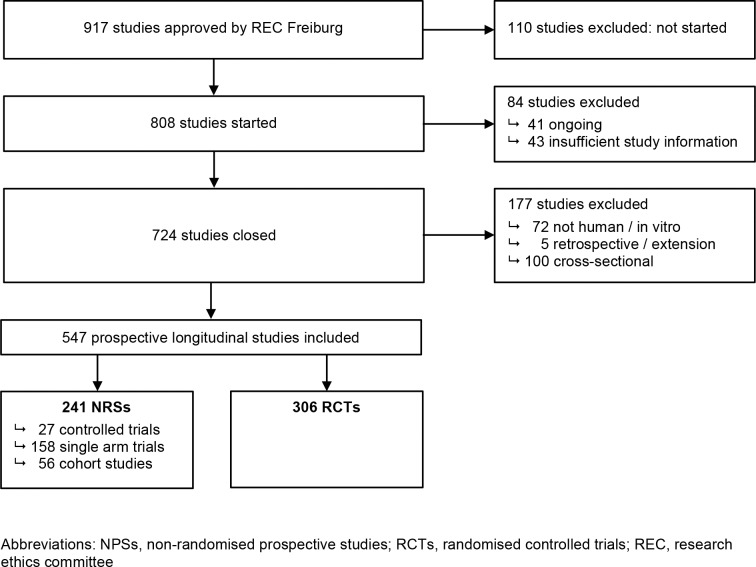
Study selection.